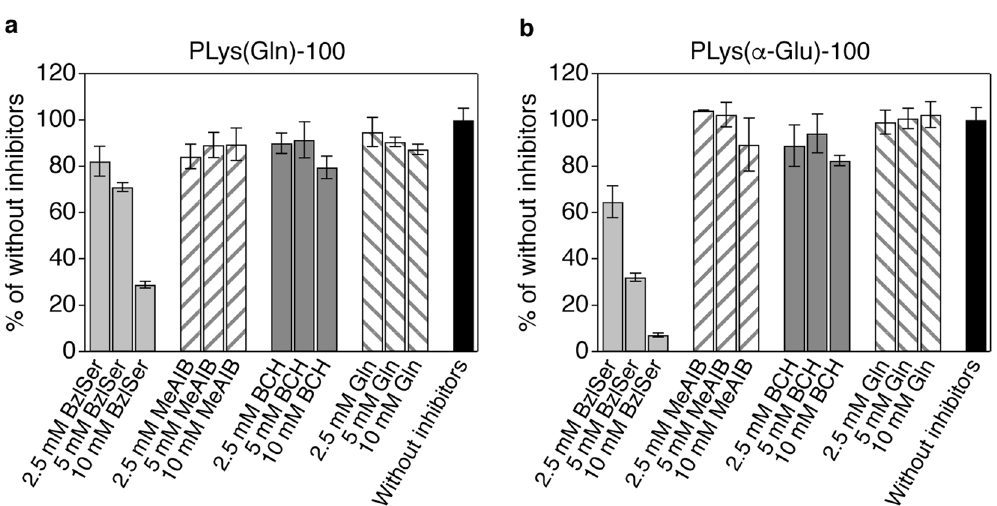
Figure 4. Cellular uptake analysis of PLys(Gln)-100 and PLys( α -Glu)-100 in the presence of transporter inhibitors. ( a , b ) Effect of inhibitors on cellular uptake of PLys(Gln)-100 ( a ) and PLys( α -Glu)-100 ( b ) in BxPC3 cells (BzlSer, ASCT2 inhibitor; MeAIB, system A inhibitor; BCH, system L inhibitor; Gln, system N inhibitor). Data are mean ± S.D. (n =